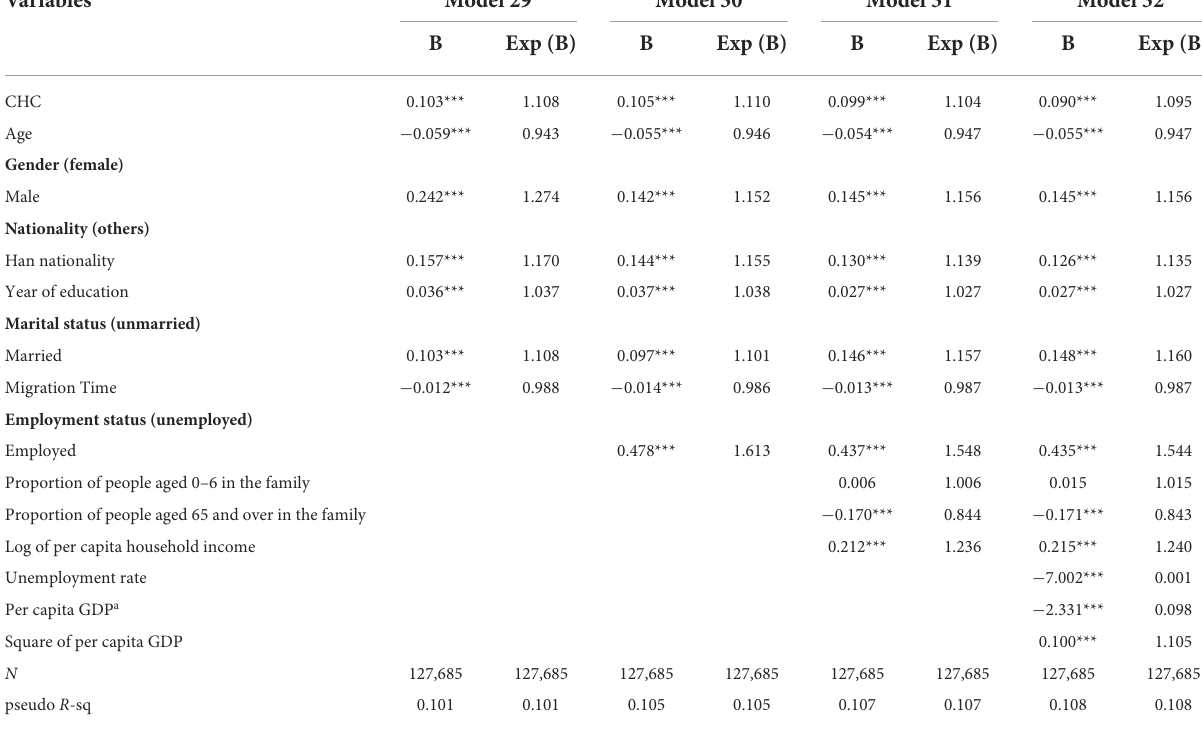
TABLE 11 Results of